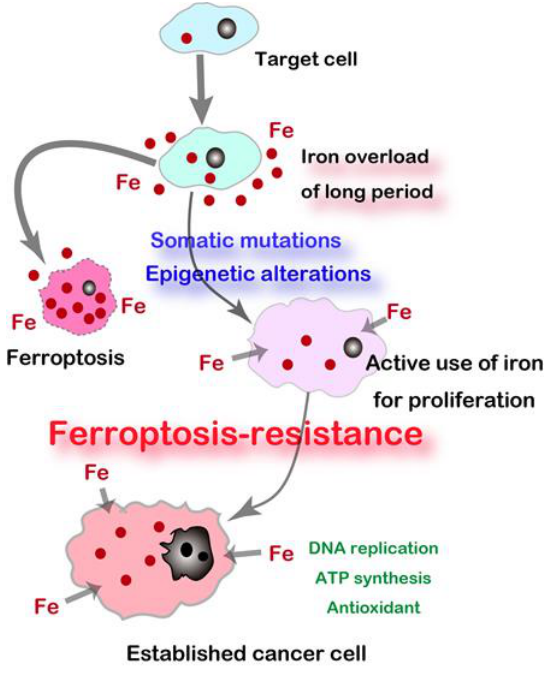
Figure 4. Carcinogenesis as a process to establish “Iron addiction and ferroptosis-resistance”. Long-term iron overload is a soil for carcinogenesis.